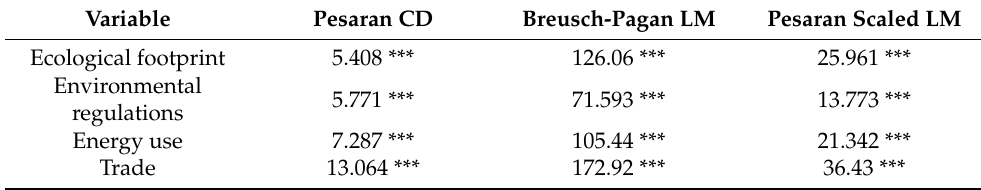
Table 3. Cross-sectional dependence test results. Variables are in logarithmic terms. Variable